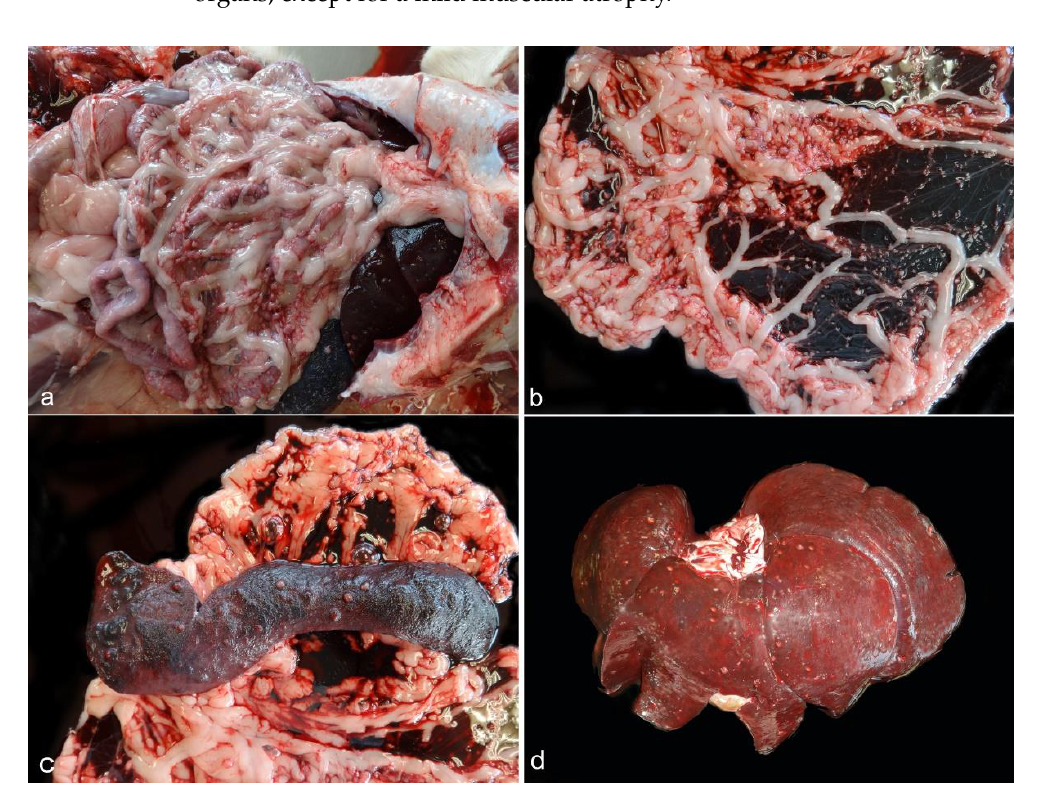
Figure 1. Peritoneum, spleen, and liver from dog 1. Multifocal whitish nodules in the peritoneum, spleen, and liver ( a ). Closer view of lesions in peritoneum ( b ), spleen ( c ), and liver ( d ). Spleen and liver appear enlarged.